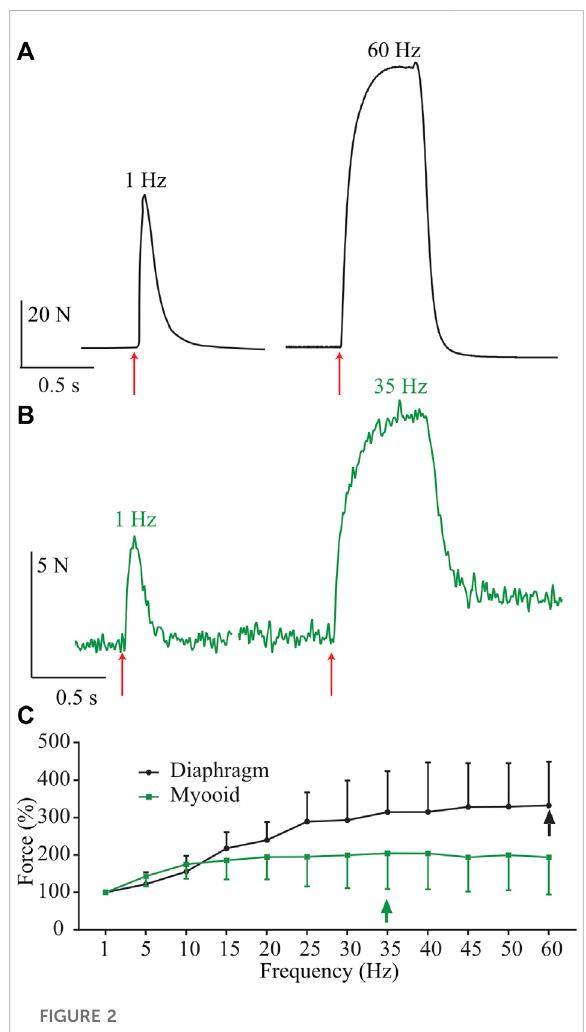
FIGURE 2 Representative traces of force production from a diaphragm strip and myooids in response to electrical stimulation. The red arrows indicate the moment of 50 V intensity and 20 ms duration for single twitch[leftsideofpanels (A,B) ],orduring 500 ms at 60 Hz for diaphragm strips (A) and 35 Hz for myooids (B) . (C) Summary analysis of the percentage of force-frequency protocol based on single twitch from six diaphragm strips (black line) and twenty myooids (green line). The arrows indicate the maximum force produced during the force-frequency protocol of up to 60 Hz of stimulation